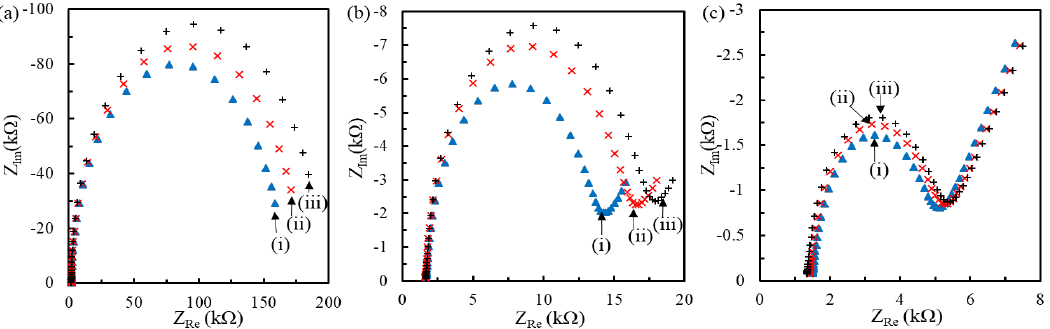
layer of 0.1:1 ( a ), 0.04:1 ( b ) and 0.02:1 ratio ( c ) followed by the hybridization of 1 pM (ii) and 1 nM (iii)